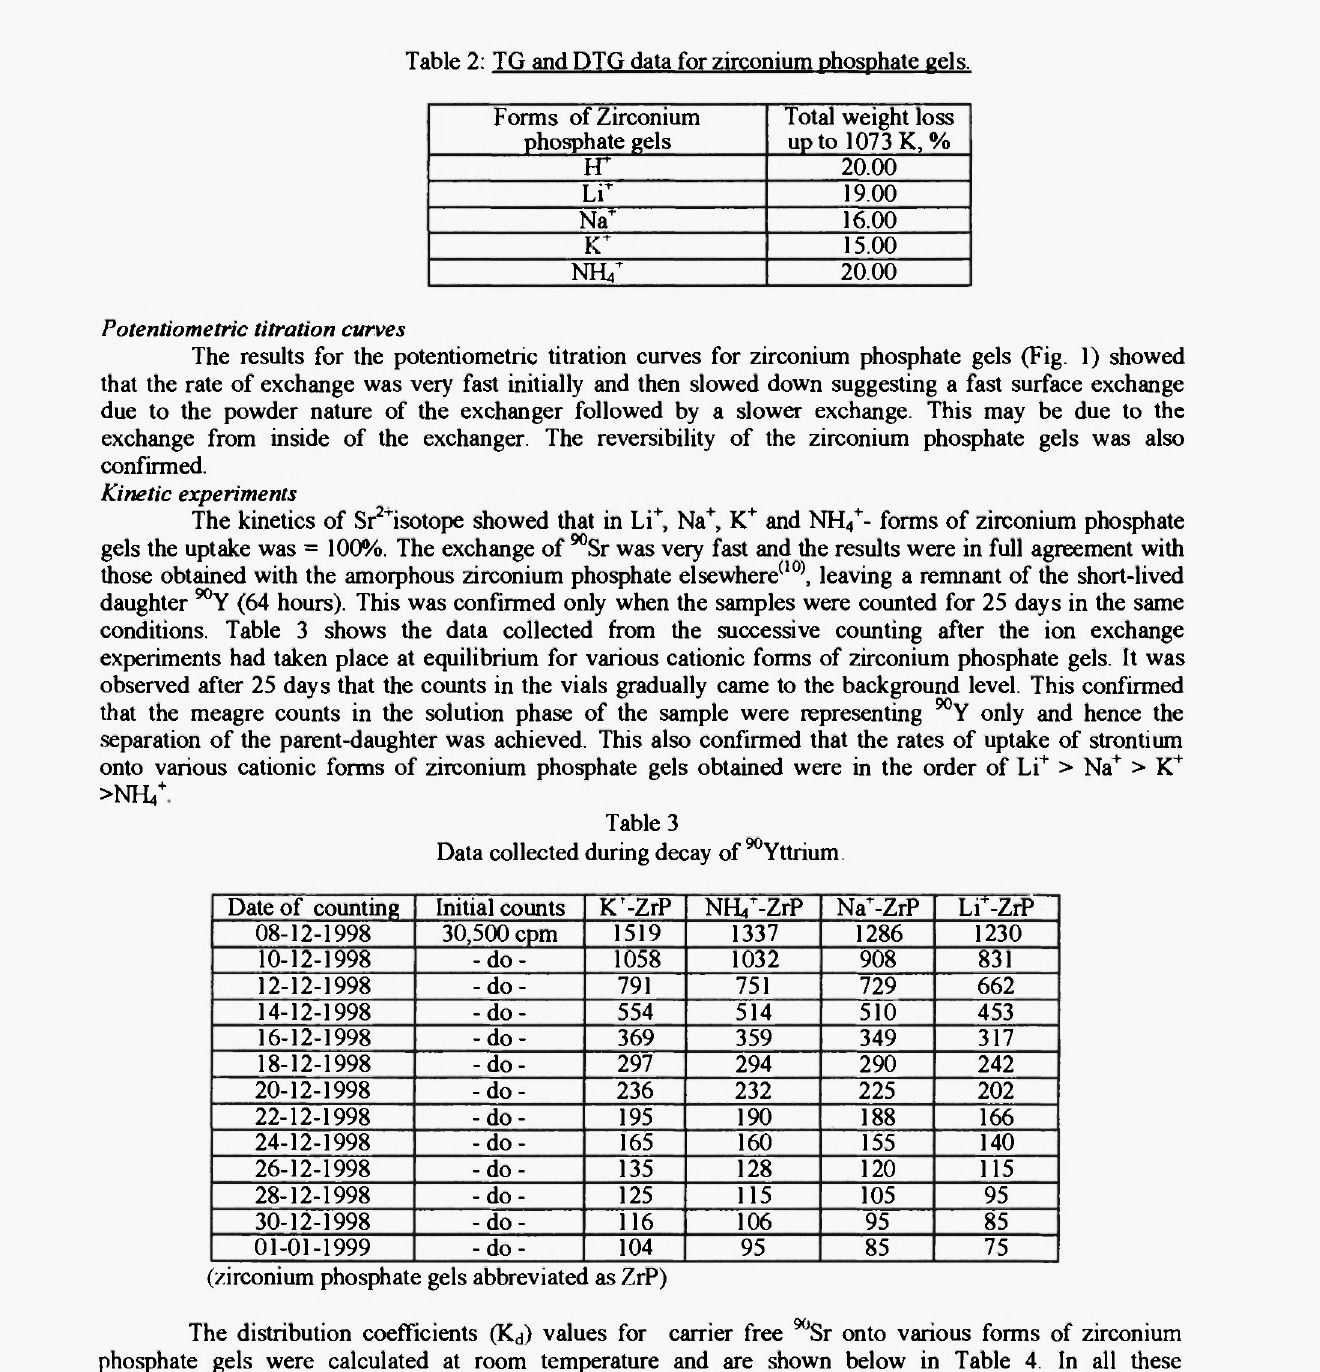
Table 2: TG and DTG data for zirconium phosphate gels.